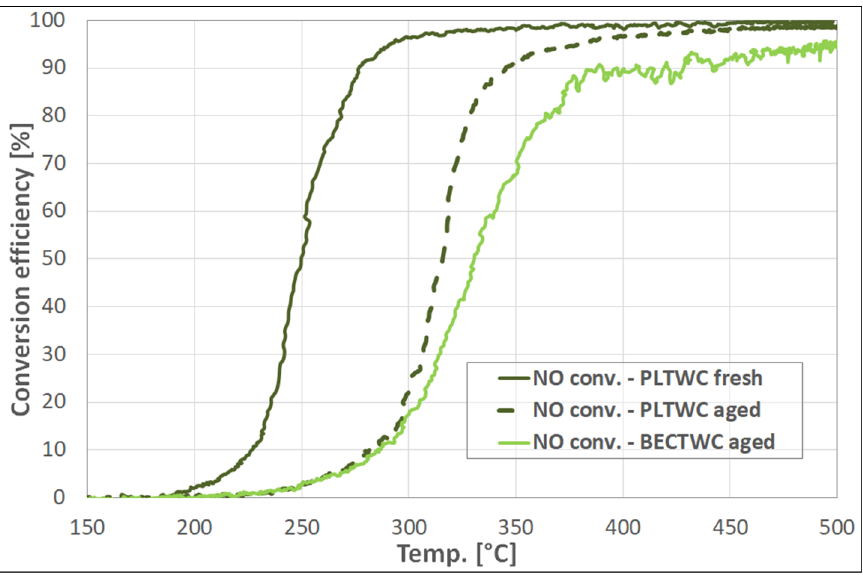
Figure 6. TWC light-off test: NO conversion efficiencies (test in RICH conditions). The light-off temperatures (T 50 values) of the TWC catalysts for the reactions studied are summarized in Figure 7. As mentioned above, tests focused on the oxidation of CO and HC were performed under a slightly lean environment of the gas mixture ( λ ≅ 1.02), while the reduction of NO x was evaluated under a slightly rich gas mixture ( λ ≅ 0.99). The most active catalyst is usually characterized by the lowest light-off temperature. As can be observed, the PLTWC fresh catalyst presented the best performance amongst the cata- lysts studied for the abatement of all pollutant gases (CO, HC, and NO). Moreover, com- paring the aged samples, the catalyst produced from recycled PGMs presented higher activity than the one synthesized with the use of commercial PGM metal precursors. Figure 7. TWC light-off test: T 50 (CO-HC-NO)—average values.